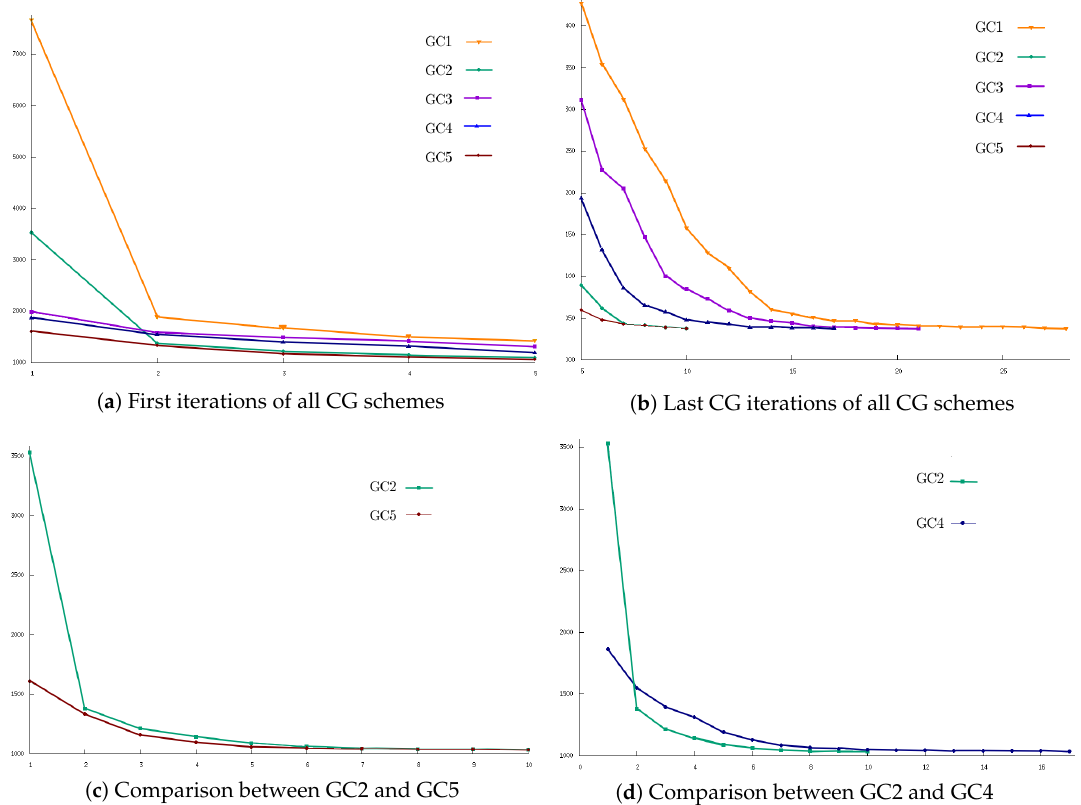
Figure 2. Comparison of the CG convergence for an instance with 40 jobs and 15 technicians with 10 different skills. For a better readability, all CG schemes are separately illustrated on the very first and the termination iterations, and comparisons between GC2 and GC5 or GC4 are shown in separate graphs.